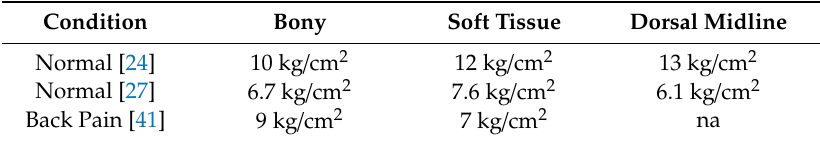
Table 8. Mean spinal MNTs at di ff erent tissue locations.